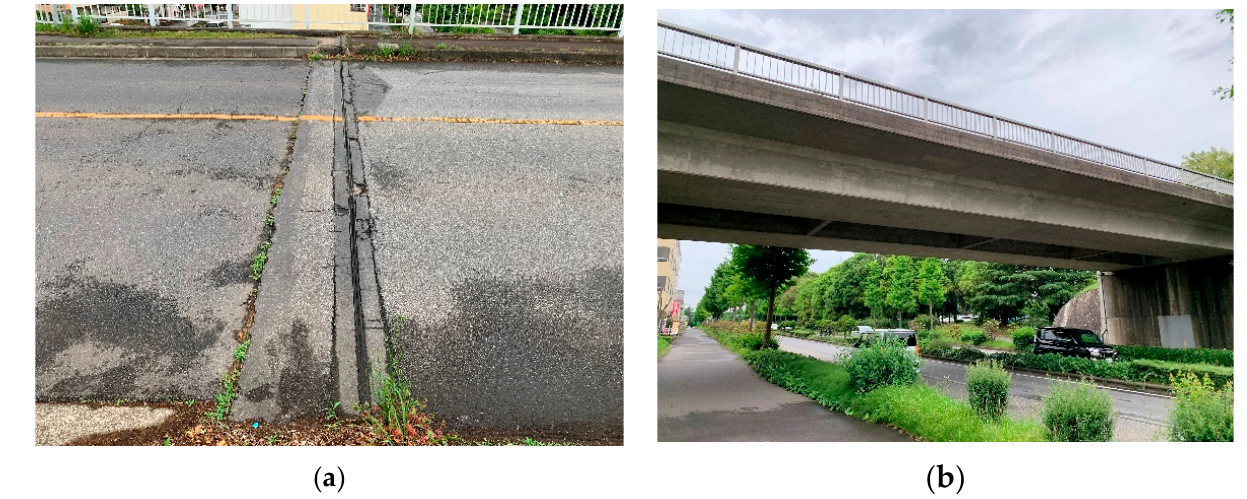
Figure 5. Photo of Bridge A: ( a ) rubber joints for bridges ; ( b ) general view.